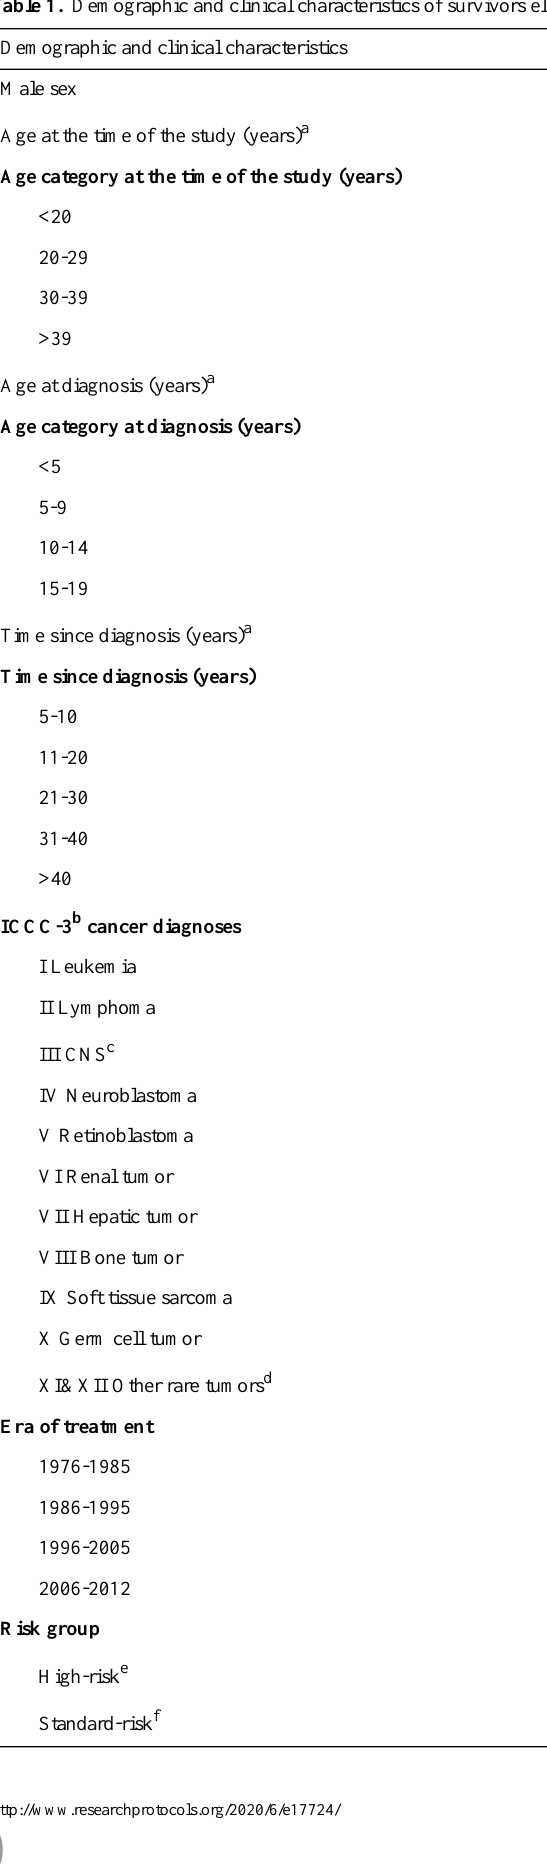
Table 1. Demographic and clinical characteristics of survivors eligible for participation in the cohort study (n=544), as of January 1,